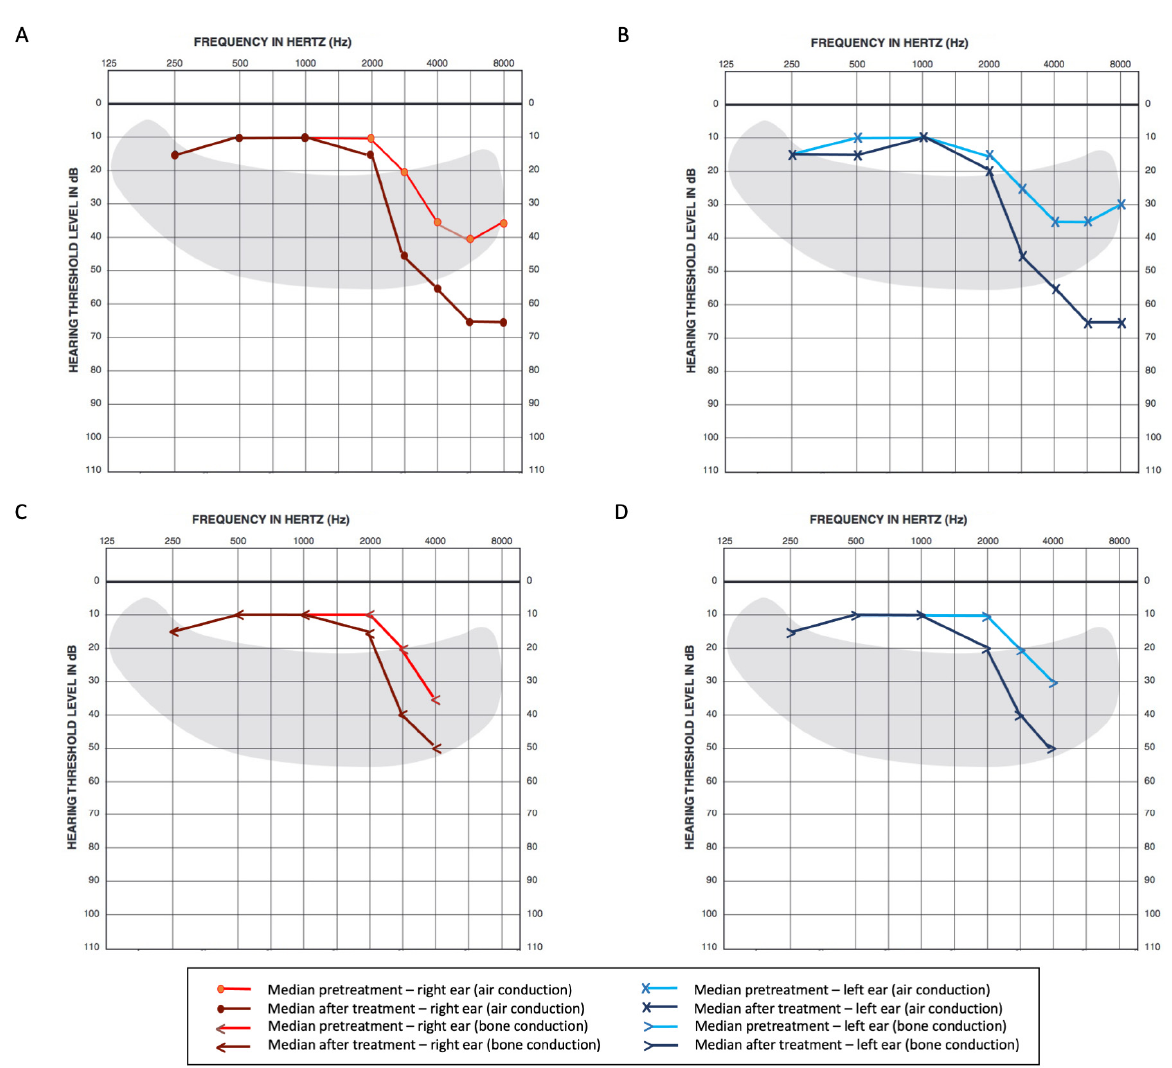
Figure 3. Pure tone thresholds (medians) pre- and post-cisplatin exposure in air and bone conduction audiometry. ( A ) Pure tone thresholds (medians) for 0.25, 1, 2, 3, 4, 6, and 8 kHz in air conduction for the right ear, ( B ) Pure tone thresholds (medians) for 0.25, 1, 2, 3, 4, 6, and 8 kHz in air conduction for the left ear, ( C ) Pure tone thresholds (medians) for 0.25, 1, 2, 3 and 4 kHz in bone conduction for the right ear, ( D ) Pure tone thresholds (medians) for 0.25, 1, 2, 3 and 4 kHz in bone conduction for the left ear.